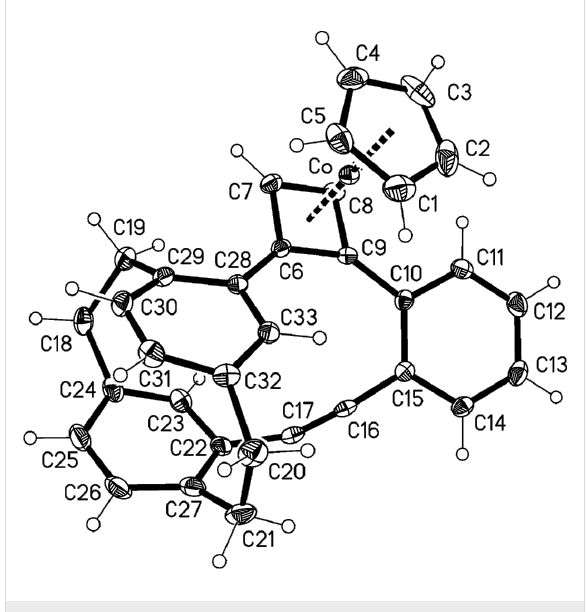
Figure 6: The molecule of compound 26 in the crystal; ellipsoids represent 50% probability levels.